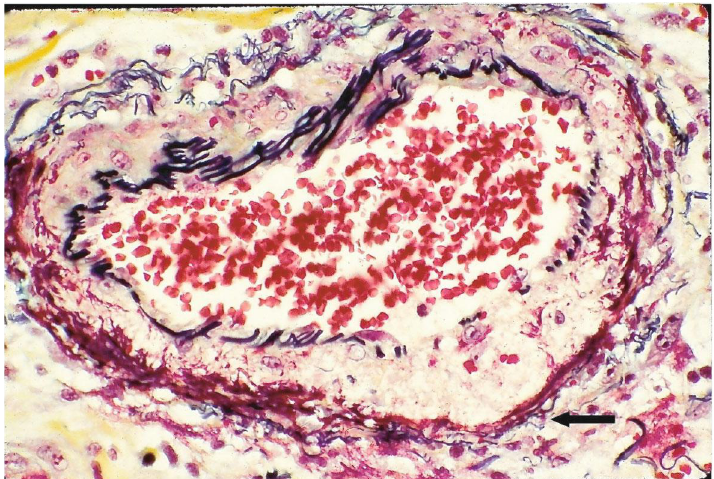
Figure 11: Segmental arterial mediolysis injurious phase. The arrow points to a segment of the artery showing transmural mediolysis with patchy loss of the internal elastica and intima alterations that will allow the watery medial contents to be evacuated into the blood stream creating the gaps illustrated in Figures 12 and 13. The expanded watery mediolytic contents have pushed the fi brin-lined adventitia outwards. Movat stain × 50 (adapted with permission from the American Journal of Surgical Pathology 13(7) copyright l989, Lippincott, Williams and